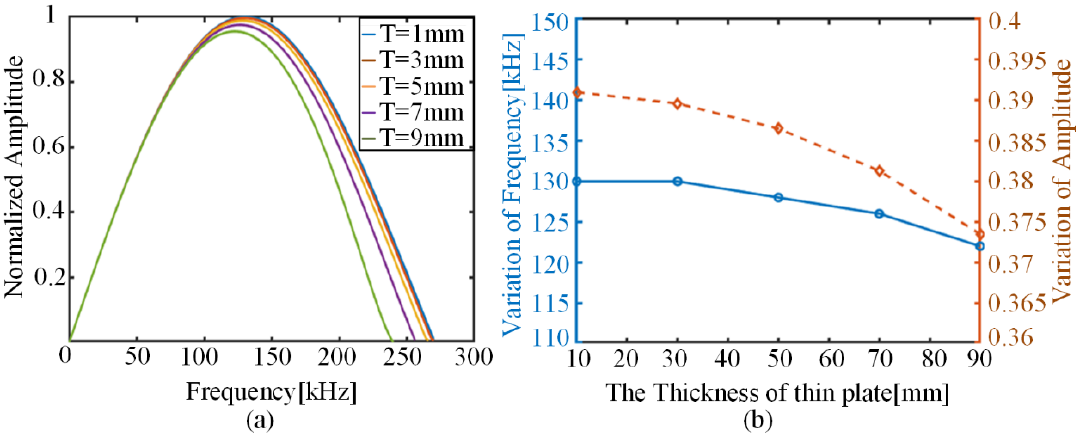
Figure 11. Variation in predicted AE results for different plate thicknesses: ( a ) variation in model-